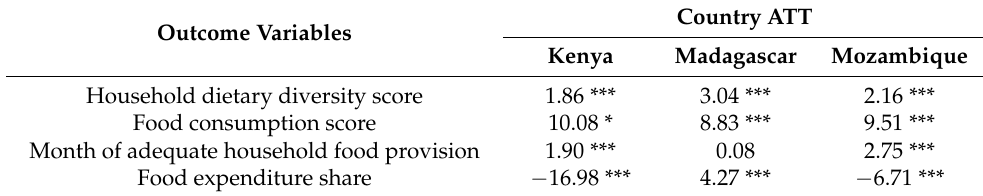
Table 9. Comparing the results of the average treatment effects for treated